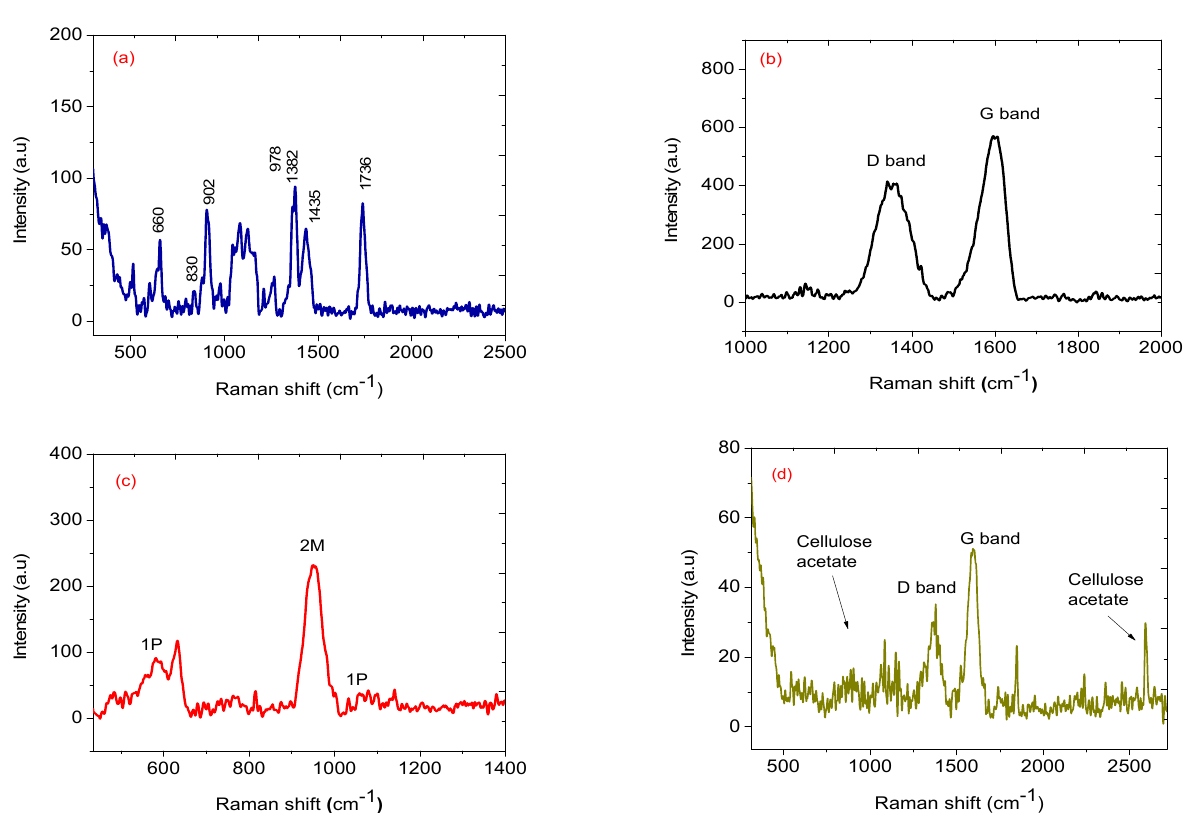
Figure 8. Raman spectra of ( a ) CA, ( b ) CNPs, ( c ) NiO and ( d ) 1:1:3 mass ratio NiO-CNPs-CA.